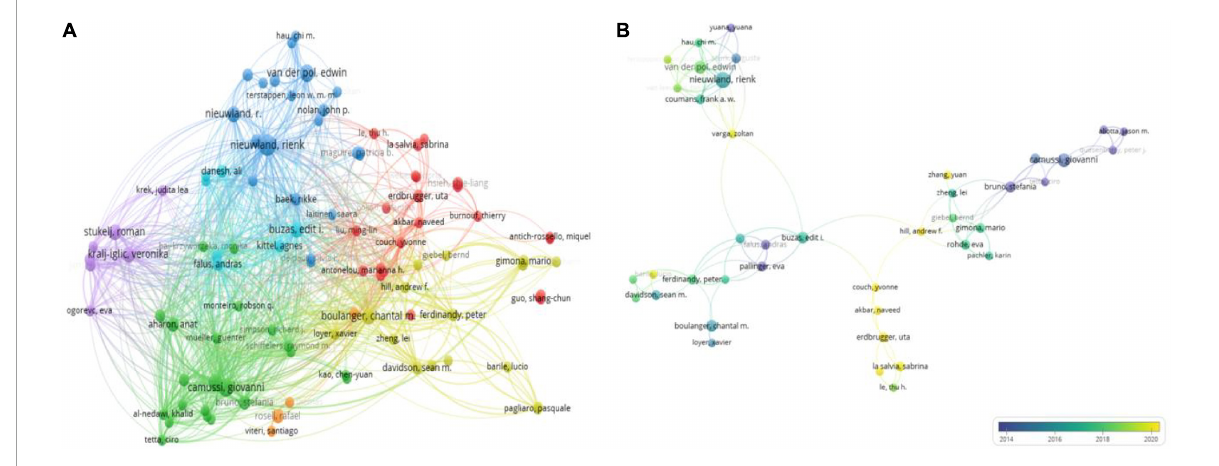
FIGURE6 Visualization map of authors involved in platelet exosome research publications. (A) Author collaboration based on VOSviewer. (B) Collaboration between co-cited authors using